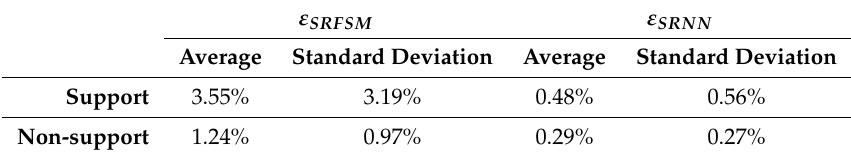
Table 1. Relative error of the cane support time and cane non-support time.